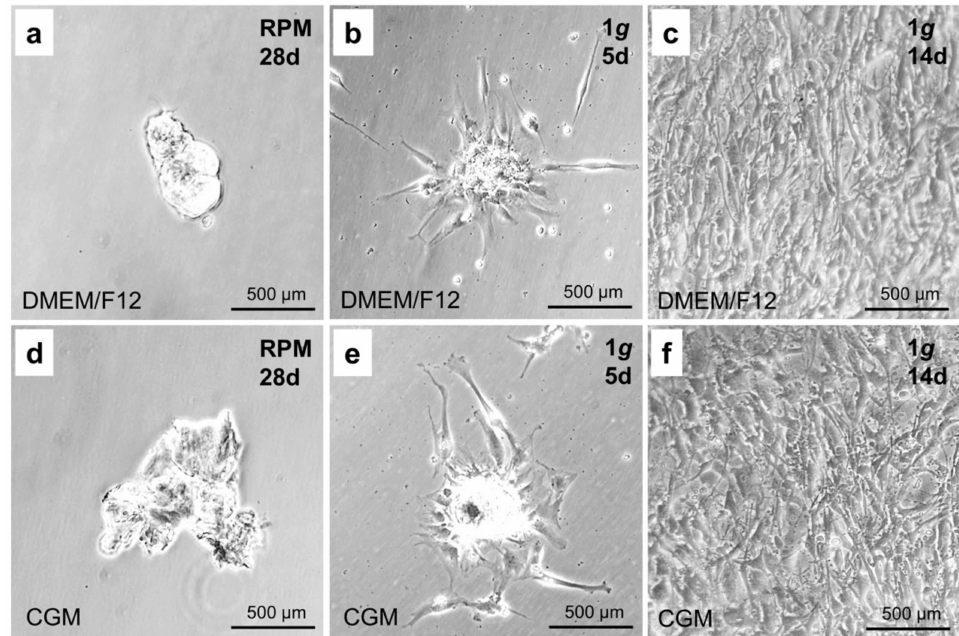
Figure 8. Spheroids produced during 28-day-cultivation on the RPM and re-cultivated under normal gravity conditions. ( a ) Microscopic analysis of spheroids produced after 28 days on the RPM in DMEM / F-12 medium. ( b ) Microscopic analysis of the spheroids produced after 28 days on the RPM in DMEM / F-12 medium after the cultivation for 5 days under normal gravity conditions (1 g ). ( c ) Microscopic analysis of the spheroids produced after 28 days on the RPM in DMEM / F-12 medium after the cultivation for 14 days under normal gravity conditions (1 g ). ( d ) Microscopic analysis of spheroids produced after 28 days on the RPM in CGM. ( e ) Microscopic analysis of the spheroids produced after 28 days on the RPM in CGM after the cultivation for 5 days under normal gravity conditions (1 g ). ( f ) Microscopic analysis of the spheroids produced after 28 days on the RPM in CGM after the cultivation for 14 days under normal gravity conditions (1 g